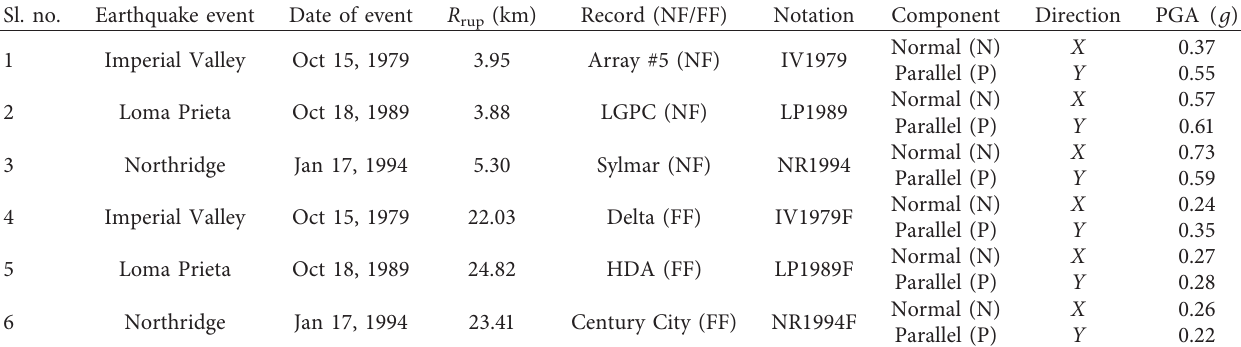
Table 2: Details of the six bidirectional earthquake ground motions used in the study. Sl.